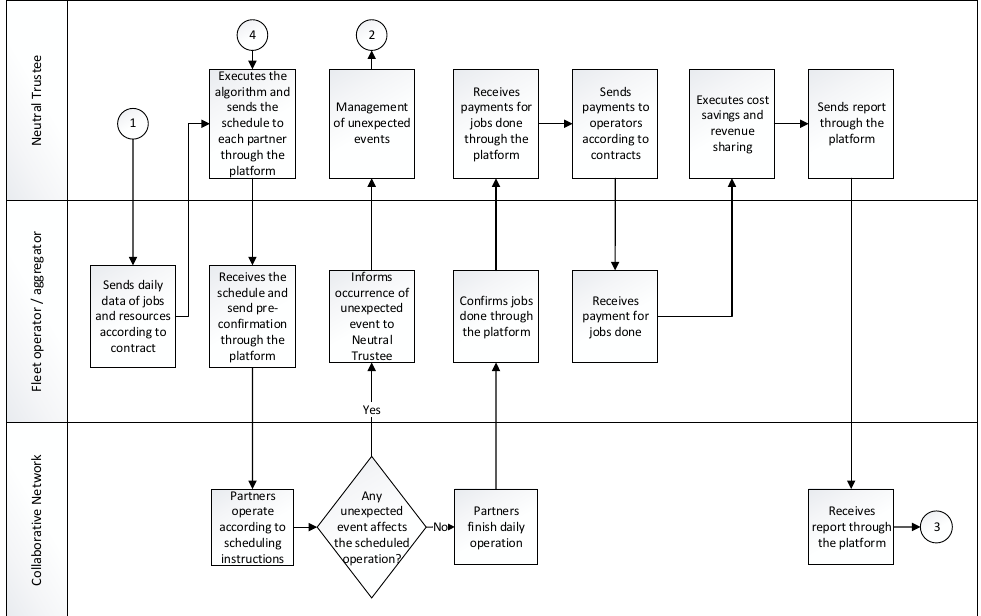
Figure 12. Workflow for proposed FSL business model—Collaboration operation.